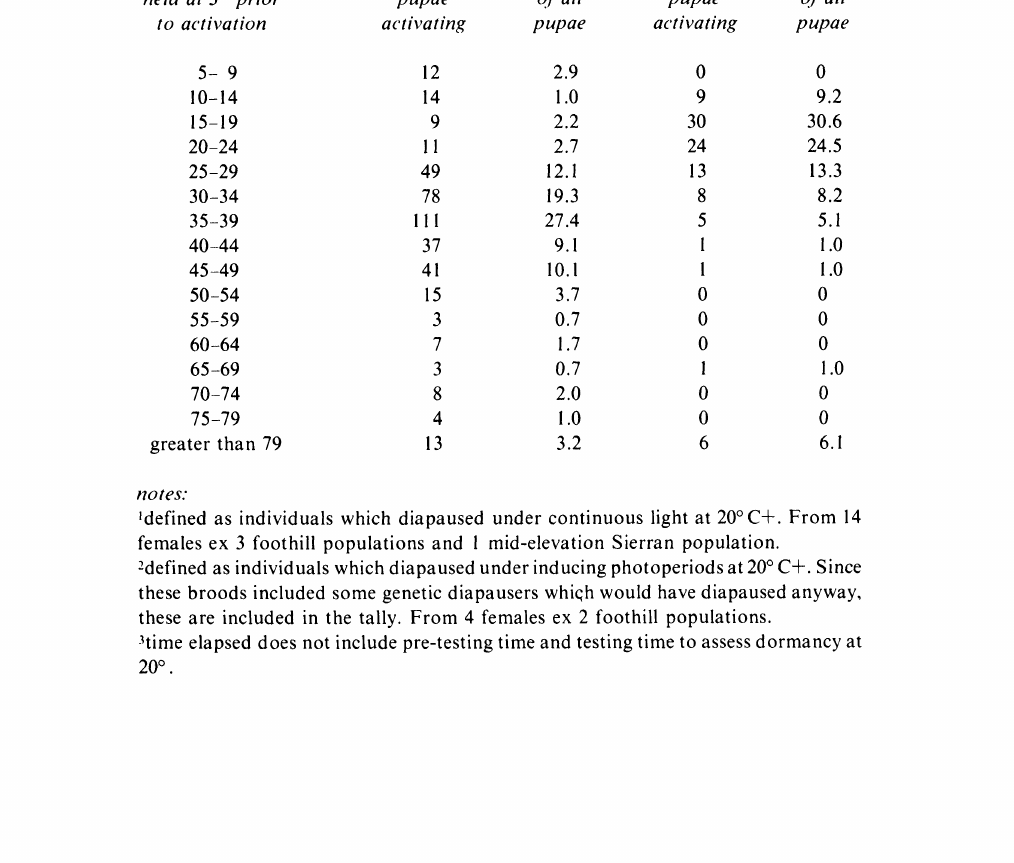
Table 3. "Chilling requirement" to break diapause in P. n. microstriata. Dormant pupae were held at 3 C and tested at intervals at 20 to ascertain whether diapause had been broken. Pooled data for several broods (see notes), 1972 through 1978.